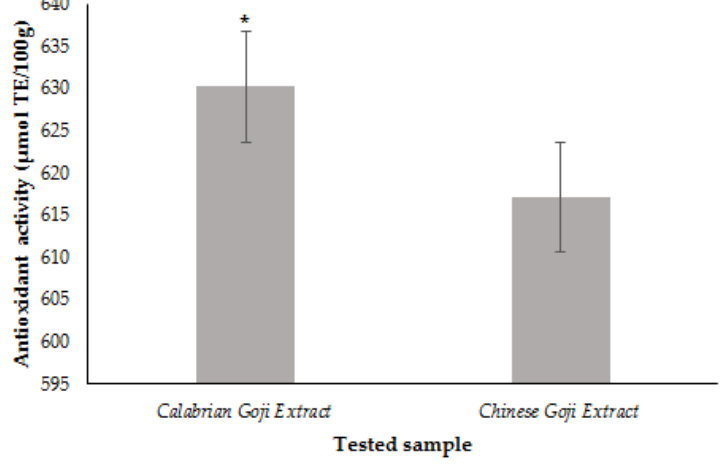
Figure 2. Antioxidant activity (ORAC values) of Calabrian and Chinese Goji extracts. ORAC values are expressed in terms of micromoles of trolox equivalents per 100 g of dry weight. Values are the mean ± SD. Significance was defined as * p < 0.05.